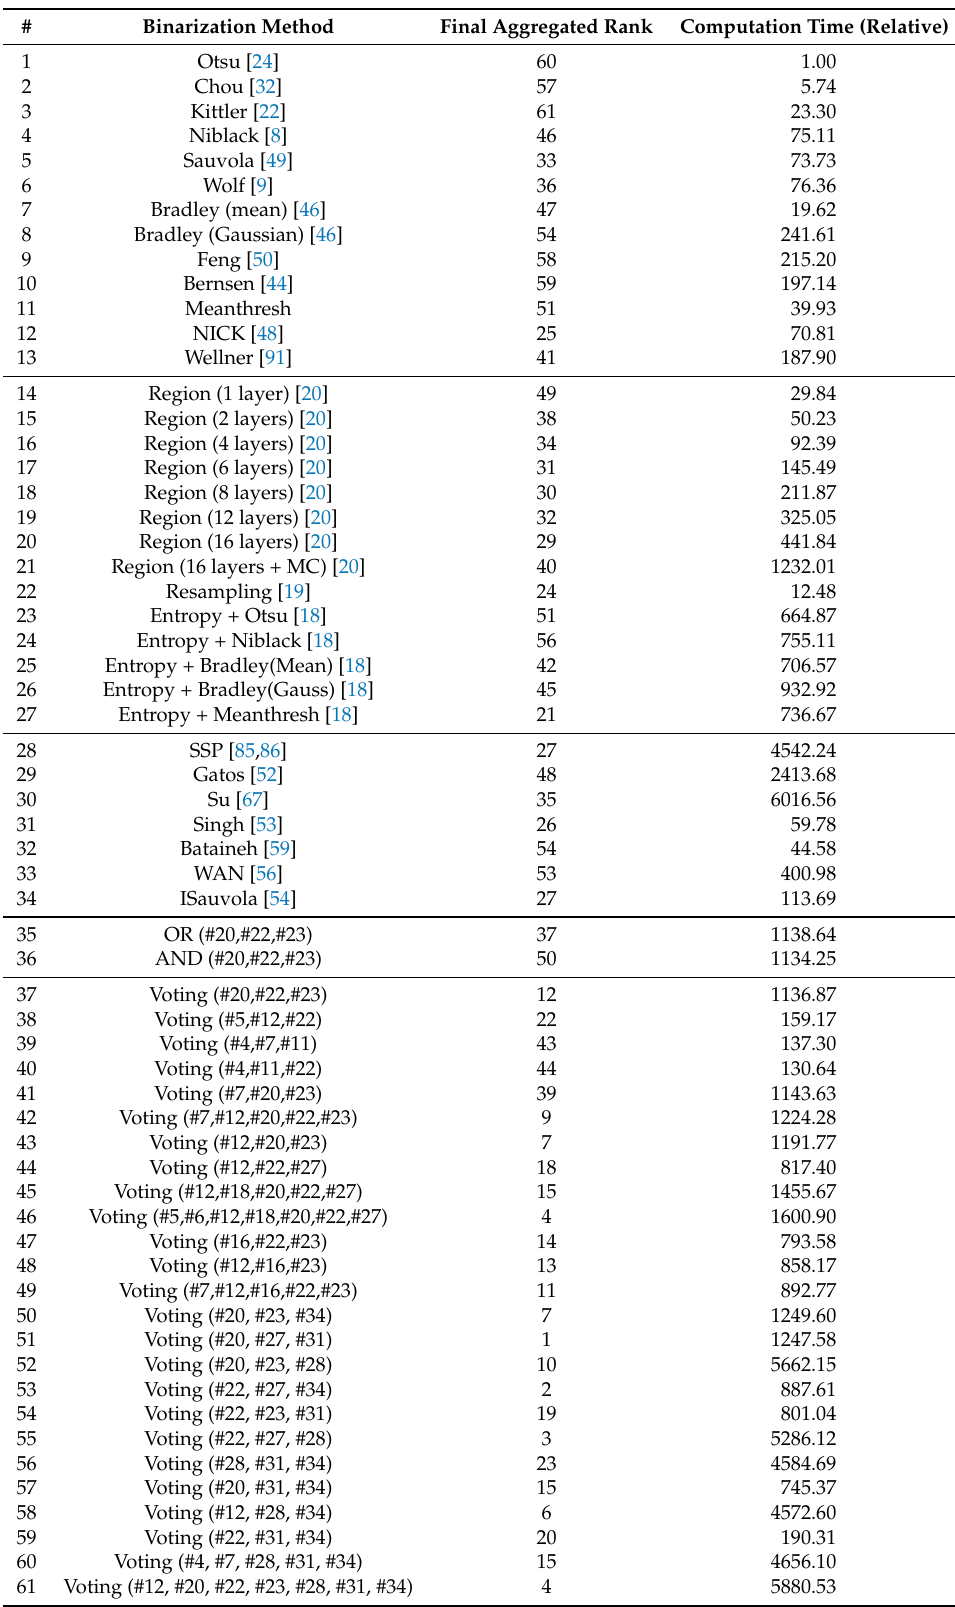
Table 4. Comparison of the overall rank scores for 3 OCR engines and average computational time relative to Otsu’s method obtained for 176 document